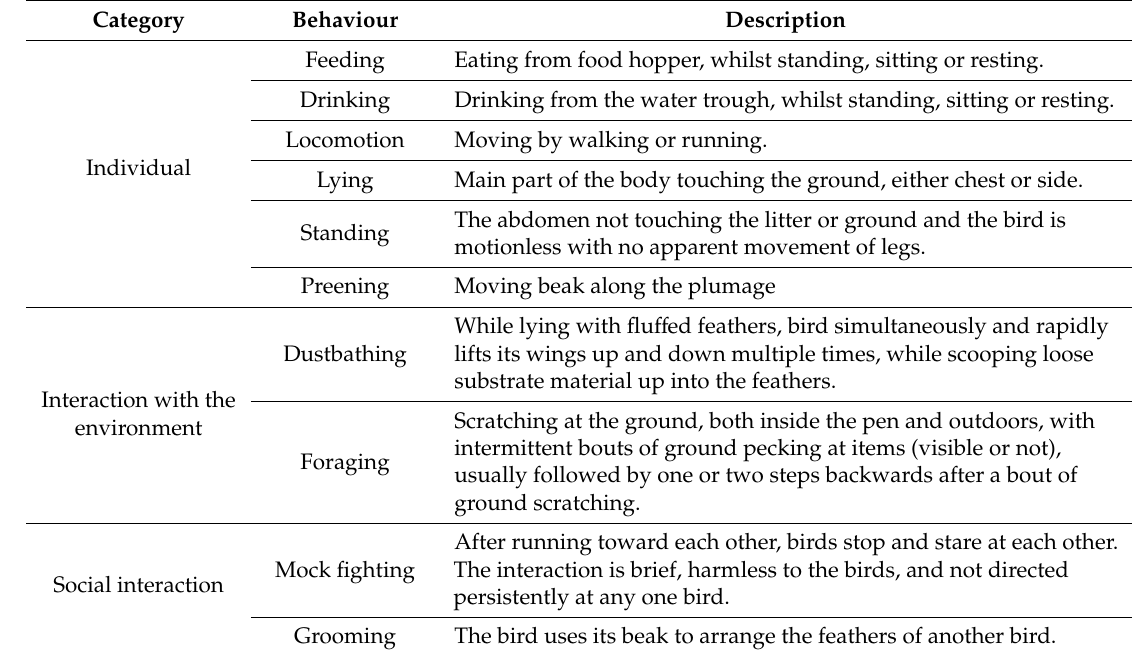
Table 1. Ethogram of 11 mutually exclusive behaviours, designed following a programme of ad libitum sampling of commercial-line